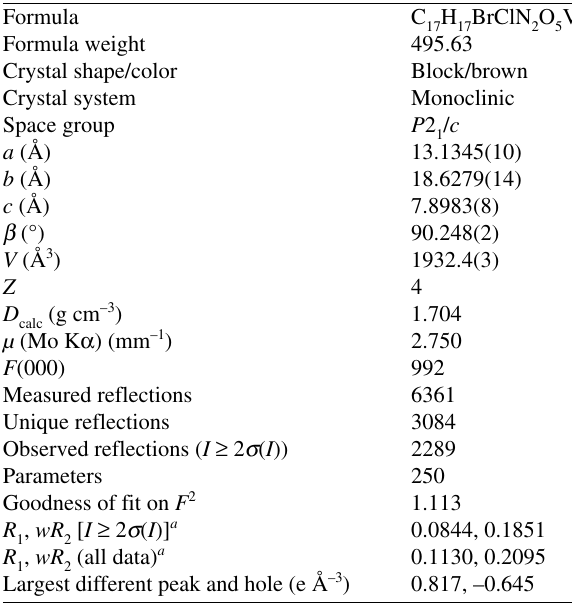
Table 1. Crystallographic information for the complex